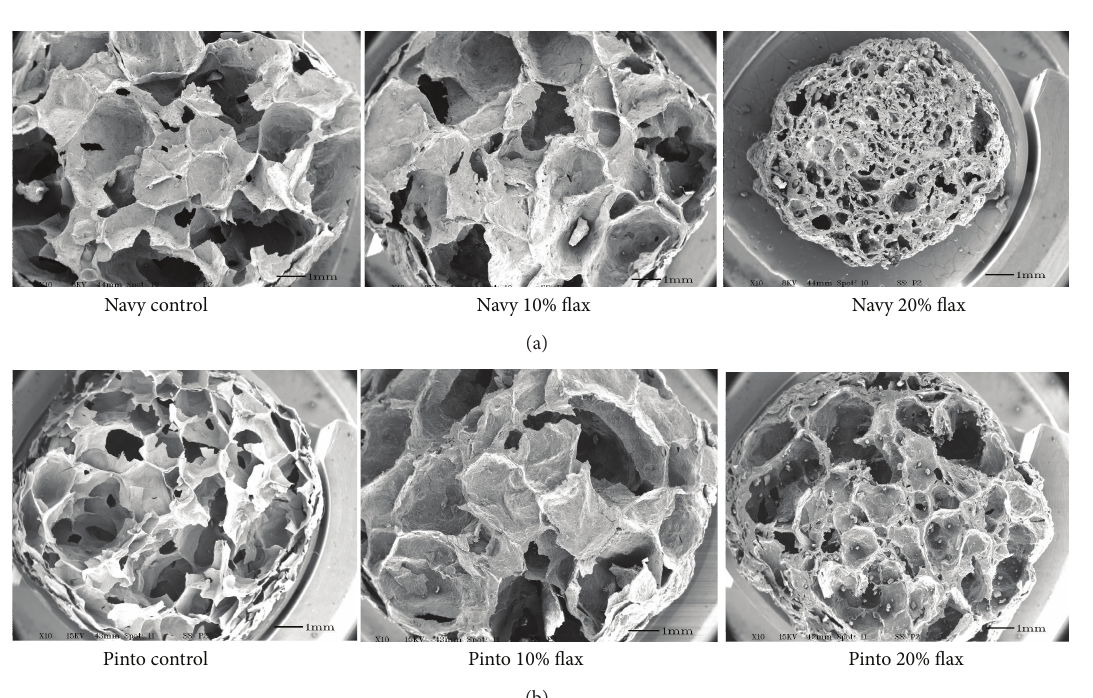
Figure 2: Scanning electron micrographs ( × 550 magnification) of extrudates obtained from combinations of bean flour and corn (i.e., navy or pinto control) and either 10 or 20%